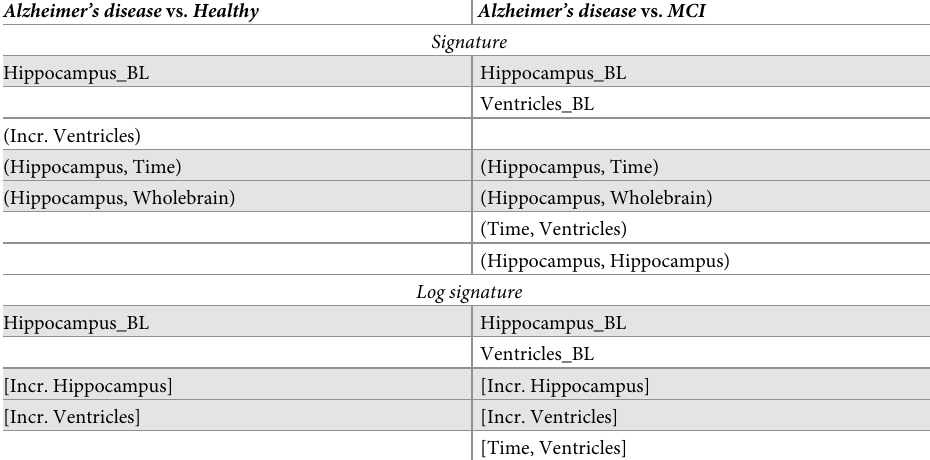
Table 2. The set of variables selected by Lasso for classification of Alzheimer’s disease vs . a healthy diagnosis (left column) and Alzheimer’s disease vs . MCI (right column). Highlighted rows show variables that are selected by both classification tasks. The baseline value of a variable is denoted by the suffix _BL. First order terms such as (Incr. Ventri- cles) denote the increment of a variable and second order terms such as (Hippocampus, Time) are area terms. Highlighted rows show features selected in both classification